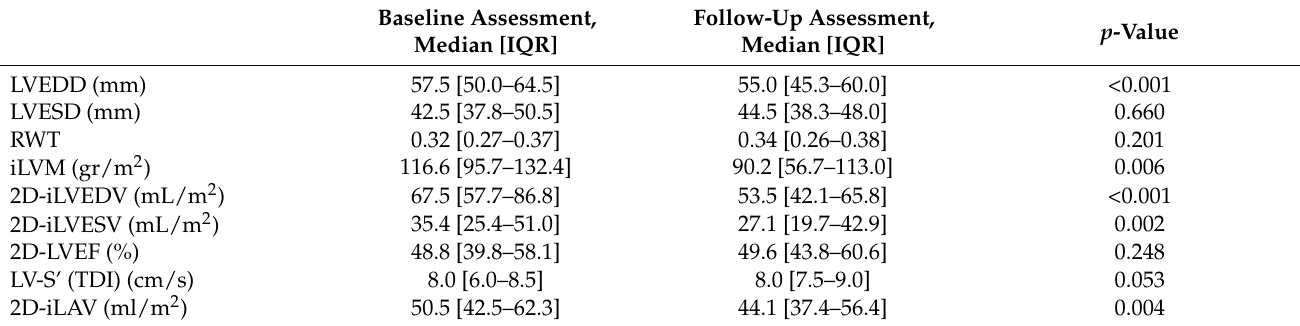
Table 3. Baseline and follow-up